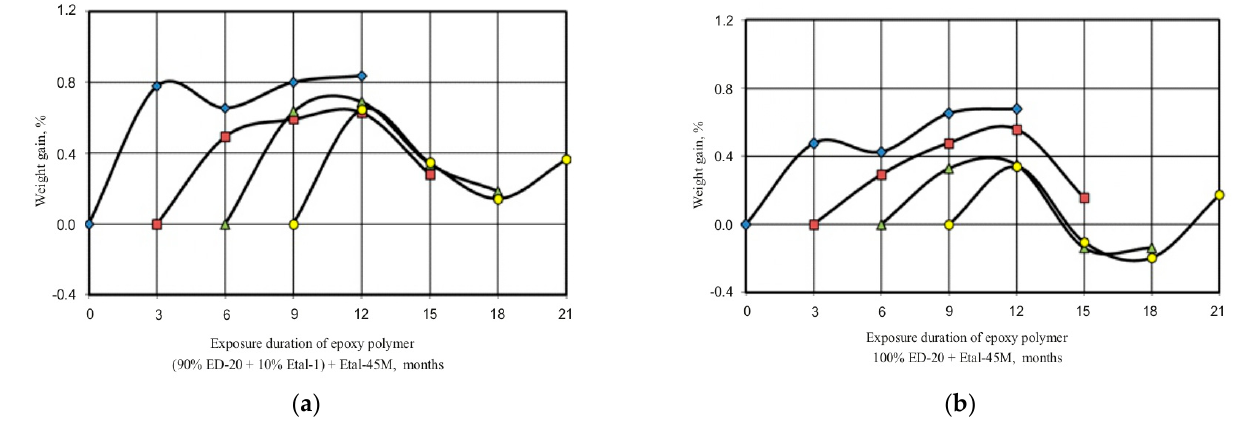
Figure 8. Change in the mass of samples of the compositions of EP (90% ED-20 + 10% Etal-1) + Etal-45M ( a ) and ED ‐ 20 + Etal ‐ 45M ( b ) relative to the common time axis for water absorption.